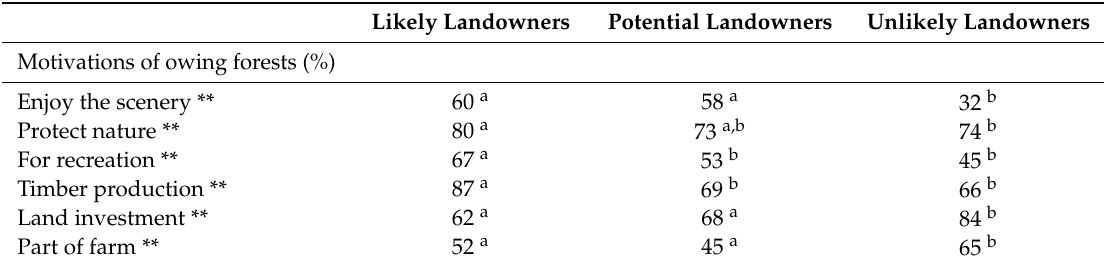
Table 4. Ownership motivations by landowners